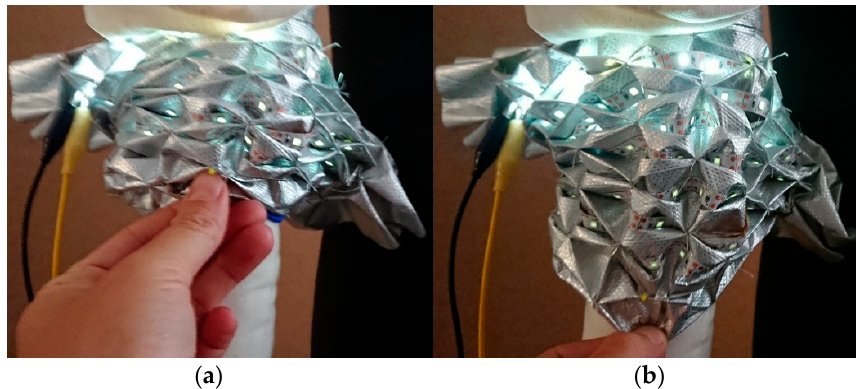
Figure 3. Mock-up 1 with light-grid function closed ( a ) and opened ( b ).